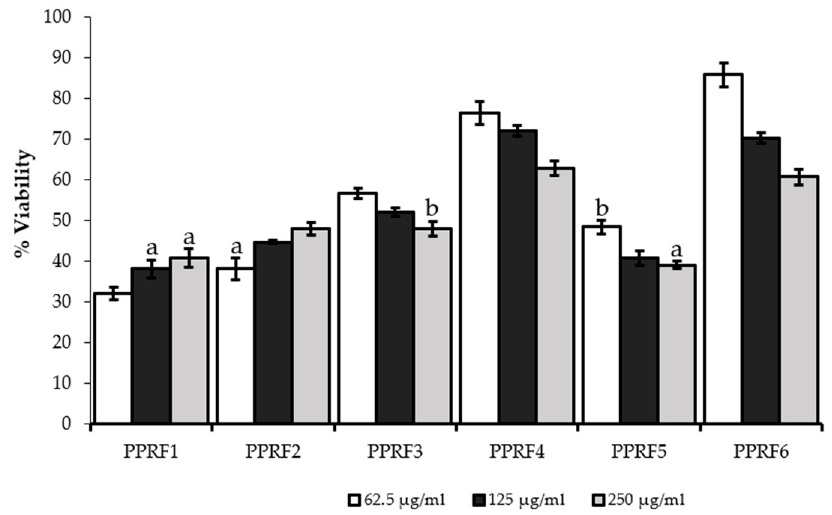
Figure 1. Cytotoxic effect of polyphenolic fractions of L. tetragona on HepG2 cells after 24 h treatment. Values are means ± SD percentage of control from three replicates of independent experiments. Bars with the same letters are not significantly different ( 𝑃 < 0.05).